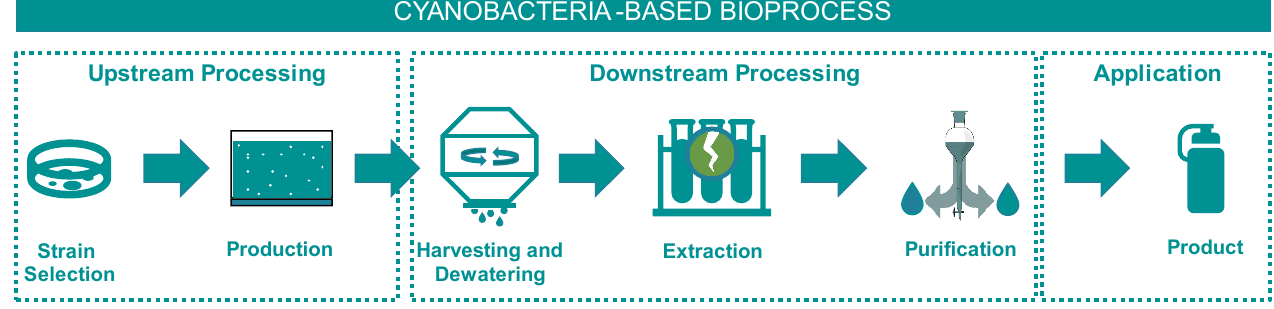
Figure 1. Overview of a general cyanobacteria-based bioprocess.